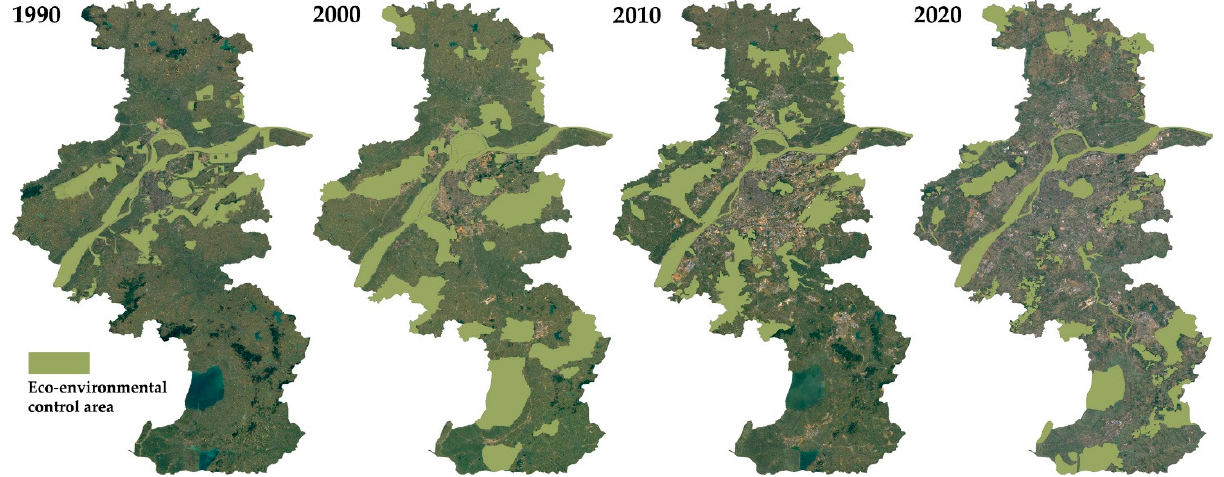
Figure 8. The change in eco-environmental control area in Nanjing over time (Figure source: own drawing; data from: [87-89]). (As the early urban expansion had not yet spread to the suburbs, the urban masterplans in 1990 and 2010 only planned for ecological conservation areas in metropolitan areas but did not clearly mark them in suburbs.)